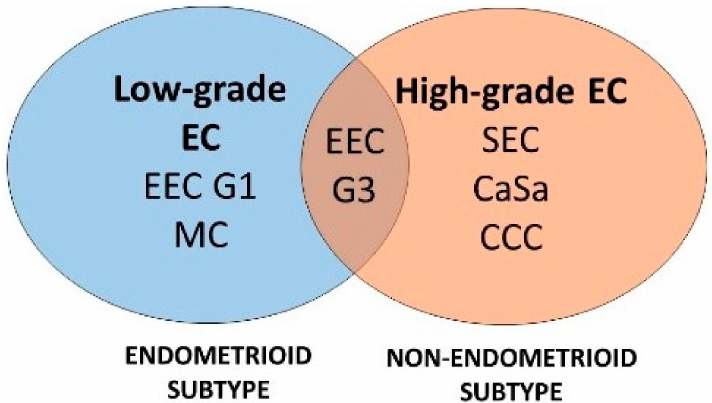
Figure 1. Study diagram of evaluated subtypes of endometrial carcinoma. Numbers of evaluated EC samples were 25, 26, 23, 21, 20, and 5 for EEC G1, EEC G3, SEC, CaSa, CCC, and MC, respec Table 1. and G3, grade 1 and grade